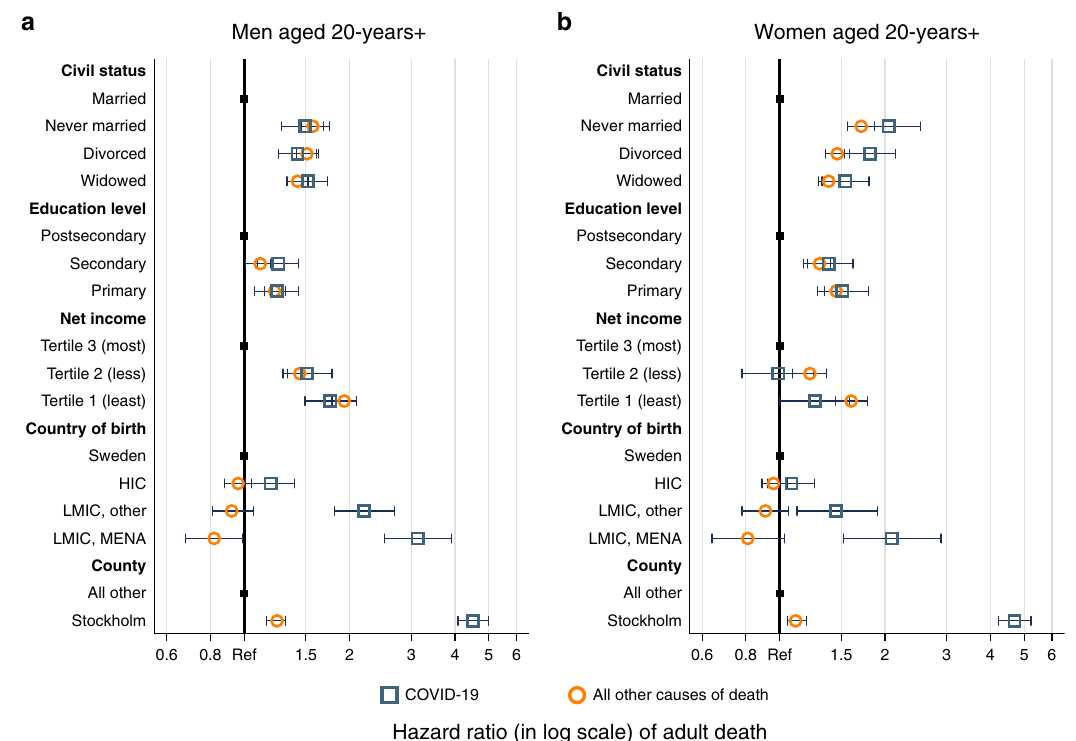
Fig. 1 Hazard ratios of dying from COVID-19 and all other causes of death for men and women in Sweden. a Men aged 20 years and older, error bars representing 95% con fi dence intervals of hazard ratios, n = 3,876,881 men. b Women aged 20 years and older, error bars representing 95% con fi dence intervals of hazard ratios, n = 3,898,173 women. Blue squares indicating COVID-19 mortality. Orange circles indicating mortality from all other causes of